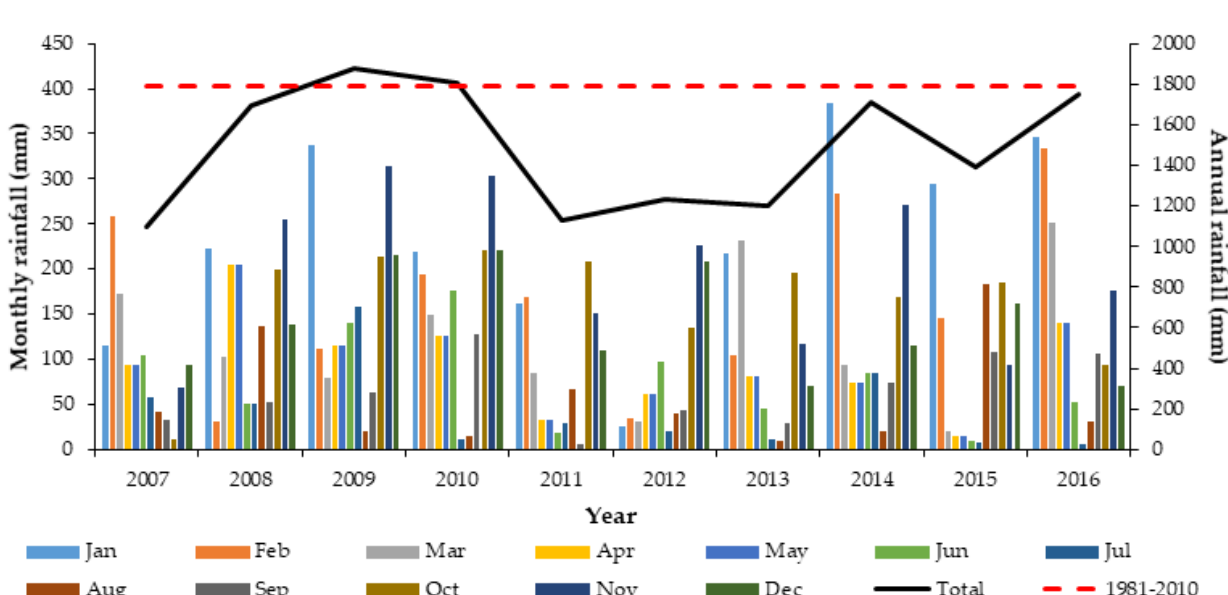
Figure 3. Monthly rainfall (mm) registered at O Abelar meteorological station during the studied years and in the period 1981–2010 (dotted red line) for the meteorological station of Santiago. Annual values are also shown (black line).